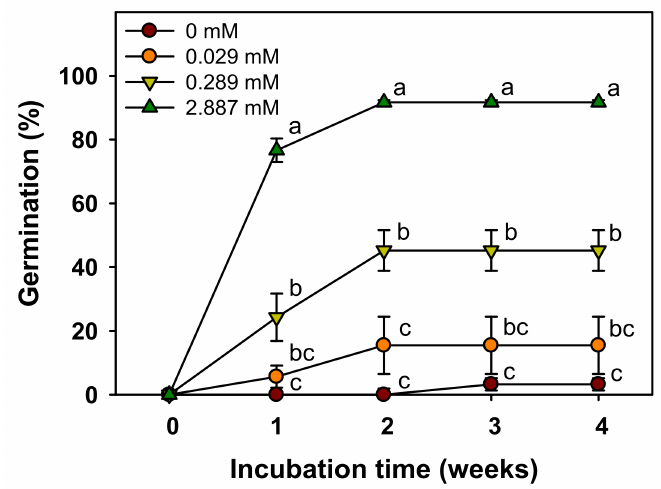
Figure 6. Effect of GA 3 treatment on germination (%) in V. sibiricum seeds in light. Seeds were incubated at 20/10 ◦ C (12/12 h). The seeds were soaked in 0, 0.029, 0.289, or 2.887 mM GA 3 solution for 24 h. Error bars indicate mean ± SE of four replicates. The different letters represent statistically significant differences for germination percentages according to treatments in each week as determined by Tukey’s HSD tests ( p < 0.05).